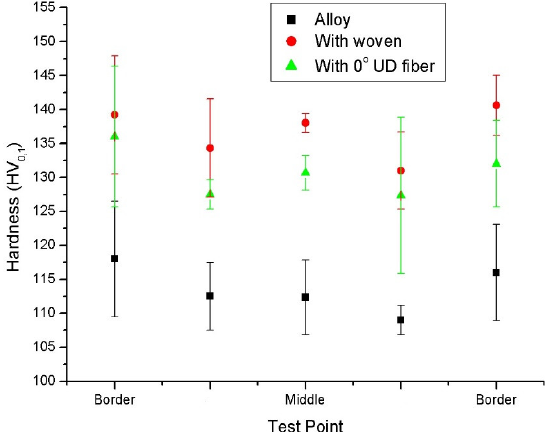
Figure 6. Vickers’s microhardness values measured on the cross-sections of the alloy and AMCs